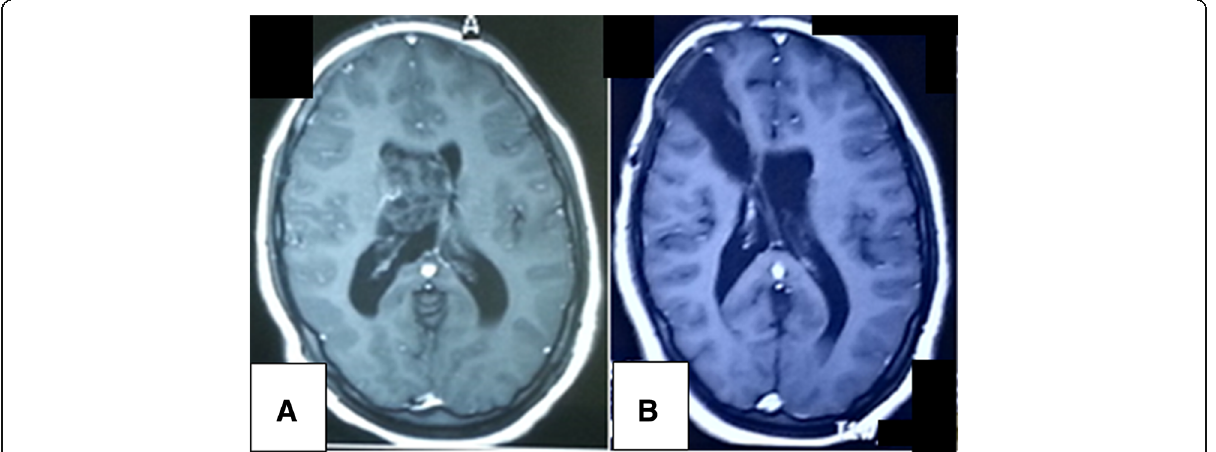
Fig. 1 Preoperative ( a ) and 12 months postoperative ( b ) axial brain contrasted T 1 magnetic resonance images for a patient where gross total resection was